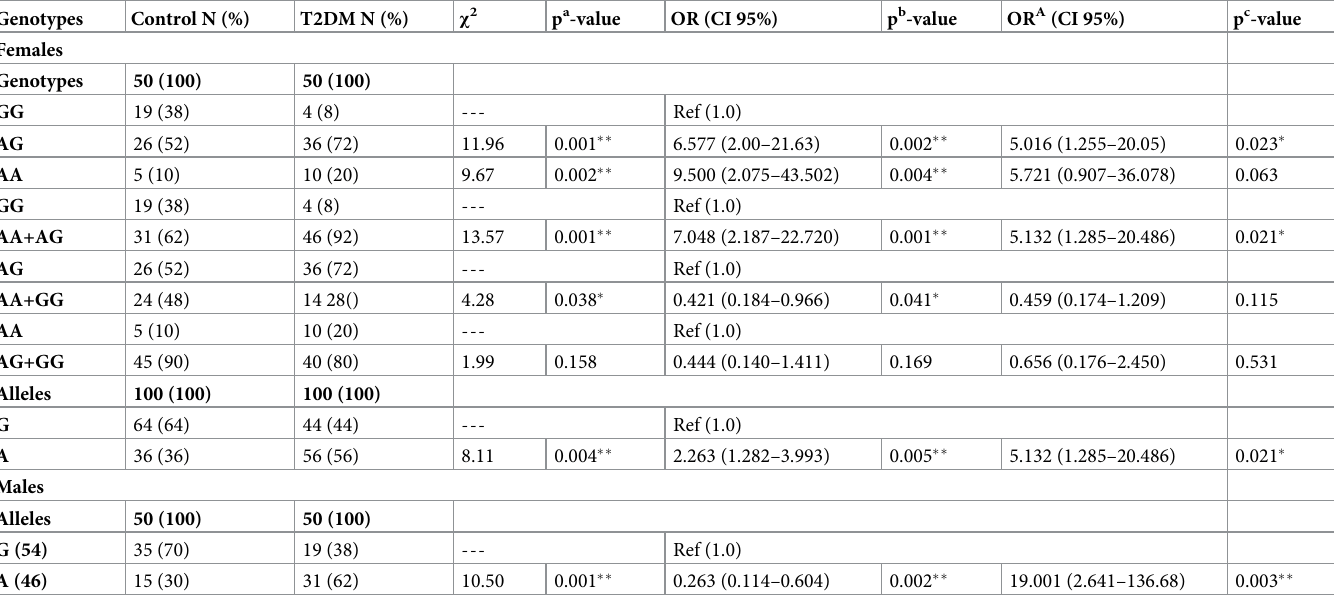
N = number of individuals. % Frequency is shown in parentheses. Differences in the frequencies of the genotypes between diabetic patients and controls were compared using Chi-square ( χ 2 ) test. Odds ratios with 95% confidence interval (95% CI) are presented and adjusted with other covariates. These are adjusted as OR A (age, BMI, T2DM duration and Smoker/Non-smoker and ACR). p a -value(chi-square p-value); p b -value (Odd ratio p-value) and p c -value (Odd ratio p-value after adjustment with other covariates). � significant at the level of 0.05 and �� highly significant at the level of